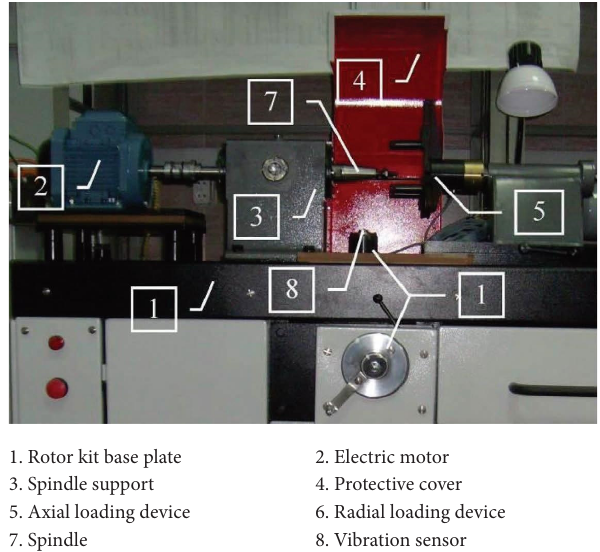
Figure 2: Mechanical part of the rotor